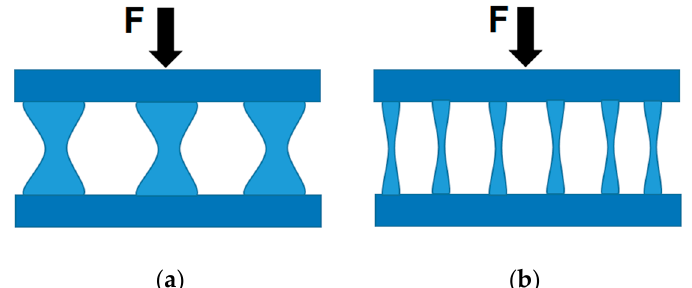
Figure 5. ( a ) Topology optimization with a smaller number of elements and ( b ) topology optimization with a larger number of elements.